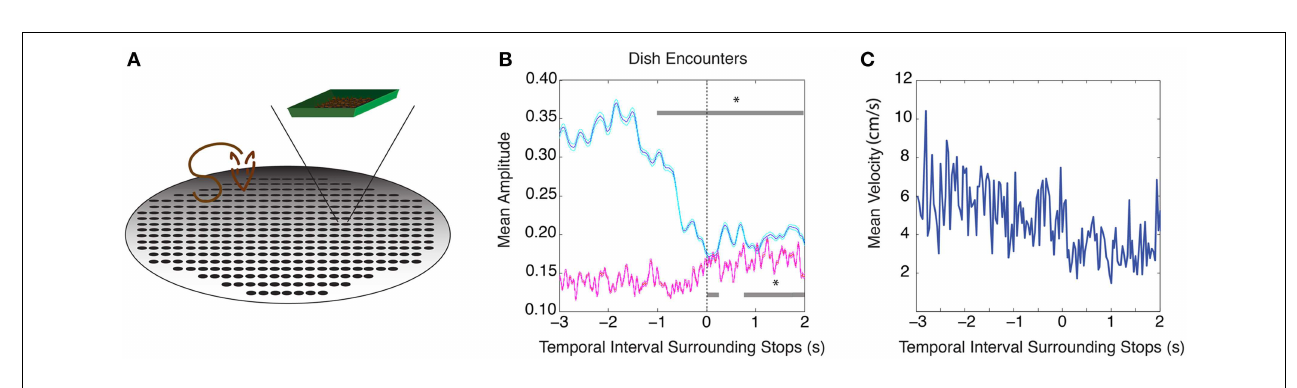
theta amplitude ( blue ) and the lower gray bar indicates 250ms bins with significant increases in beta amplitude ( red ). Error bars indicate standard error for theta ( cyan ) and beta ( magenta ) means. (C) Mean velocity during intervals surrounding stops at the conditioned cue; significant via Tukey’s HSD, * p < 0 . 05